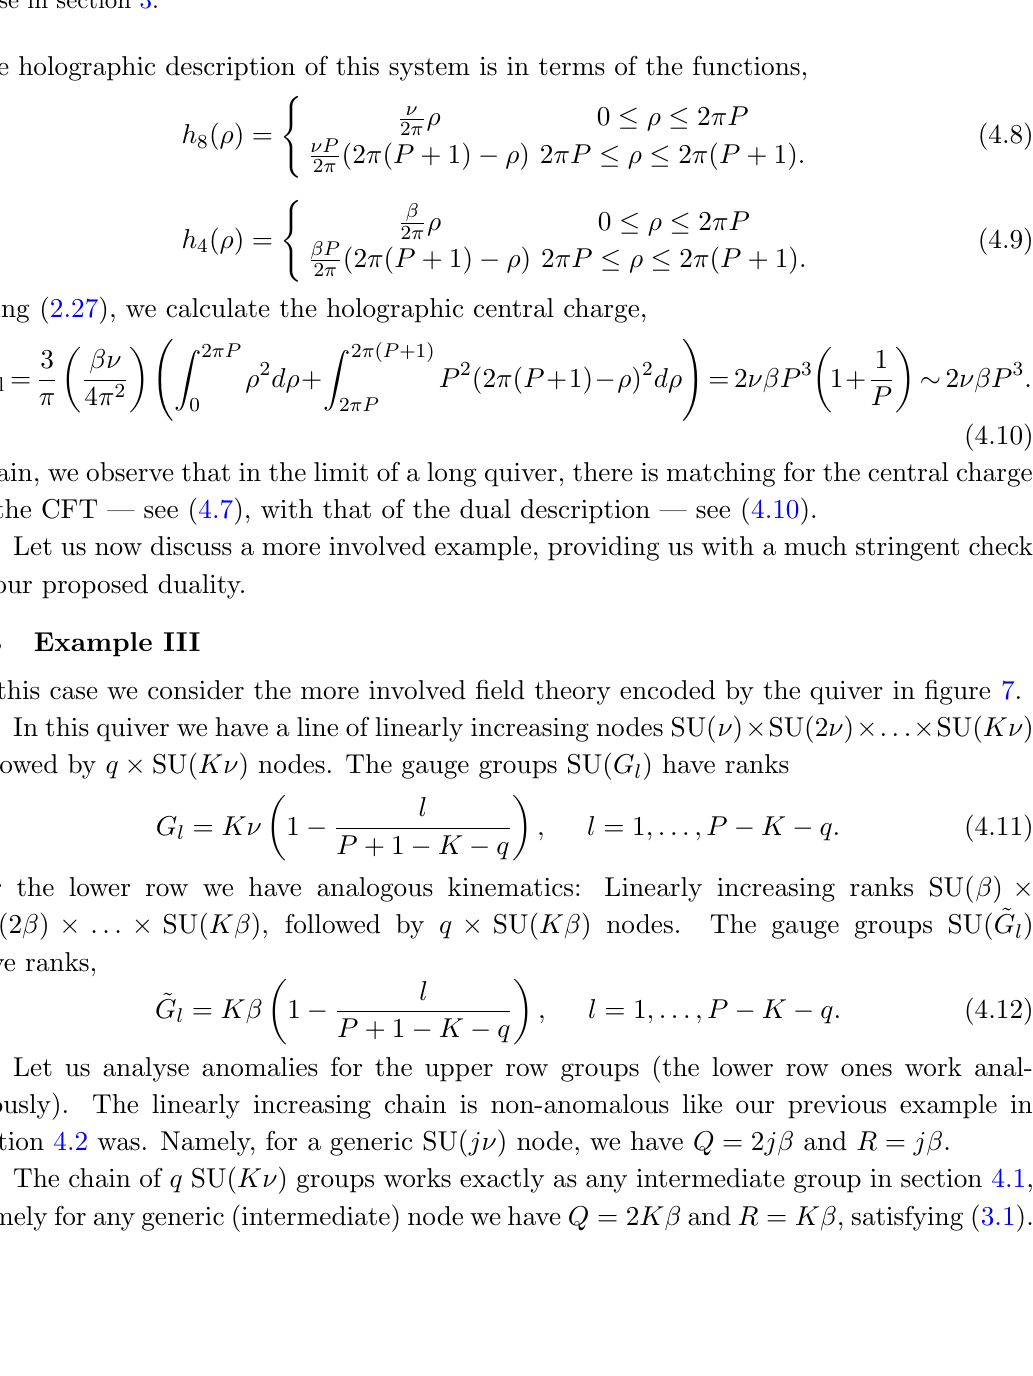
Figure 6 . The quiver encoding our second example. There are P gauged nodes with increasing rank in each row. The conventions for the (cid:12)elds running along the di(cid:11)erent lines are the same as those in section